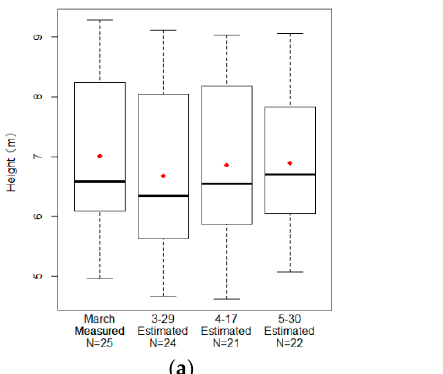
( b ) Figure 6. Tree height estimation root mean square errors (RMSEs) and R 2 values of evergreen species AS ( a ) and OF ( b ) on the three dates. The blue dots and lines are for the RMSEs, while the red dots and lines are for the R 2 values. For deciduous trees TM and FV, clear change patterns emerged, as seen from the statistics in Table 6. From March to May, as leaves became thicker in the canopy, the tree detection rate of the F score increased steadily. The estimated tree height gradually increased and approached the field- measured tree height (Figure 7; Figure 9); the tree height estimation errors (RMSE and ME) decreased significantly (Figure 8 illustrates the declining RMSE trends for TM and FV, while the R 2 increased gradually). ( b ) Figure 7. Box-and-whisker plot of measured and estimated tree heights at three dates for deciduous species TM ( a ) and FV ( b ).